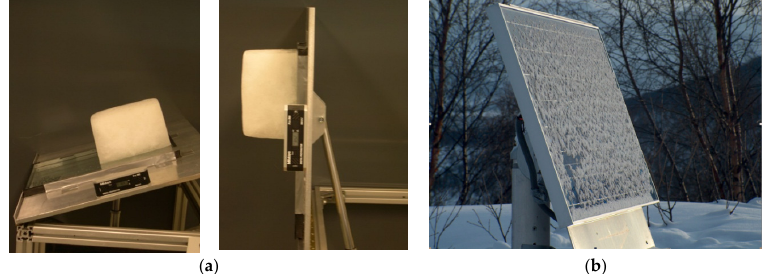
Figure 23. A snow/ice slab firmly sticking to the glass surface of an insulated window pane even at an inclination angle of 90 ° during a laboratory experiment ( a ). Snow covering a solar cell panel at an inclination angle of 70 ° ( b ) [173].